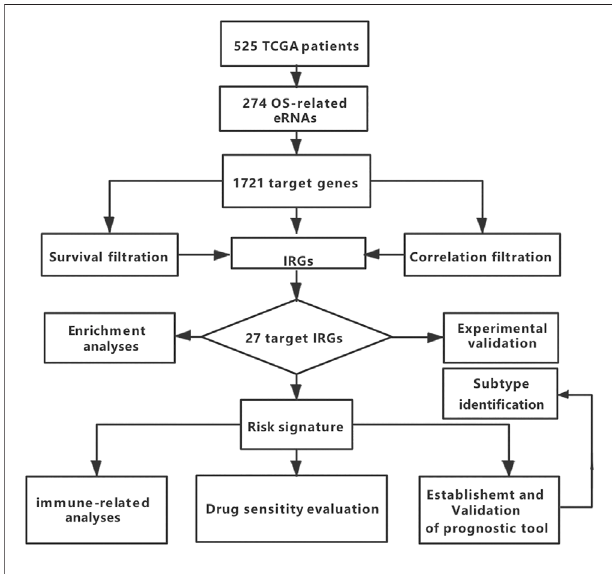
FIGURE 1 | Flowchart of the